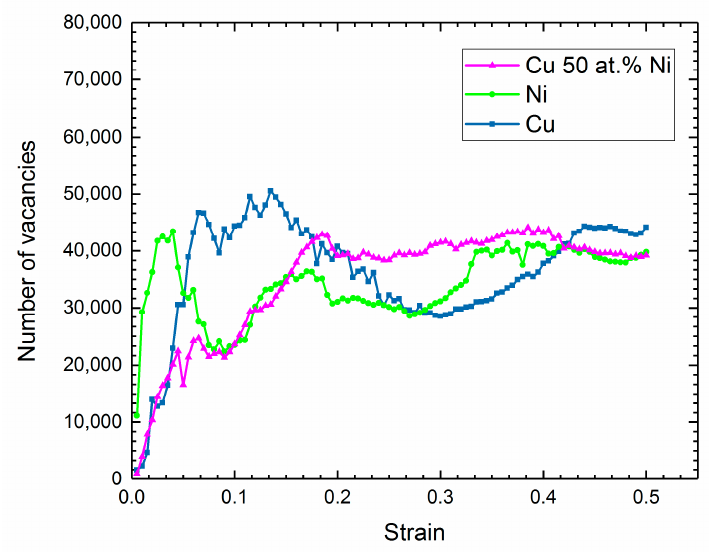
Figure 10. Number of formed vacancies during deformation as a function of strain.